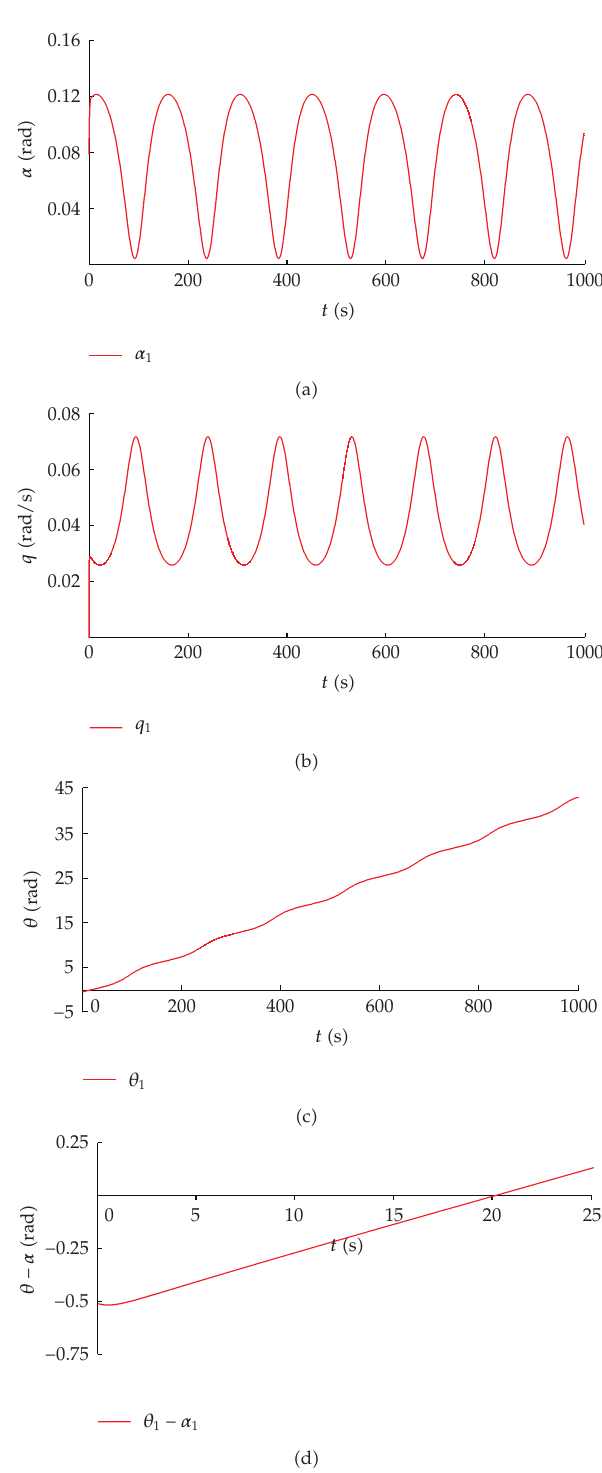
(cid:7) 0 (cid:5) rad / s (cid:6) ; θ (cid:6) (cid:7) − 0 . 428832 (cid:5) rad (cid:6) (cid:7) − 24 . 58 ◦ into 1 1